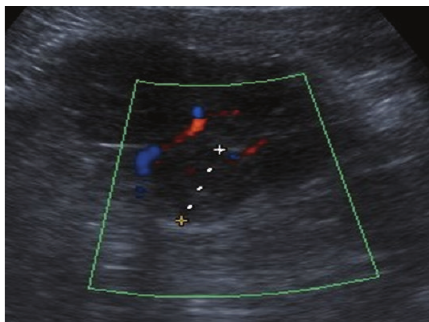
Figure 3: Renal ultrasound demonstrates an exophytic hypoechoic solid mass arising from the lower pole of the kidney consistent with a renal cell carcinoma.